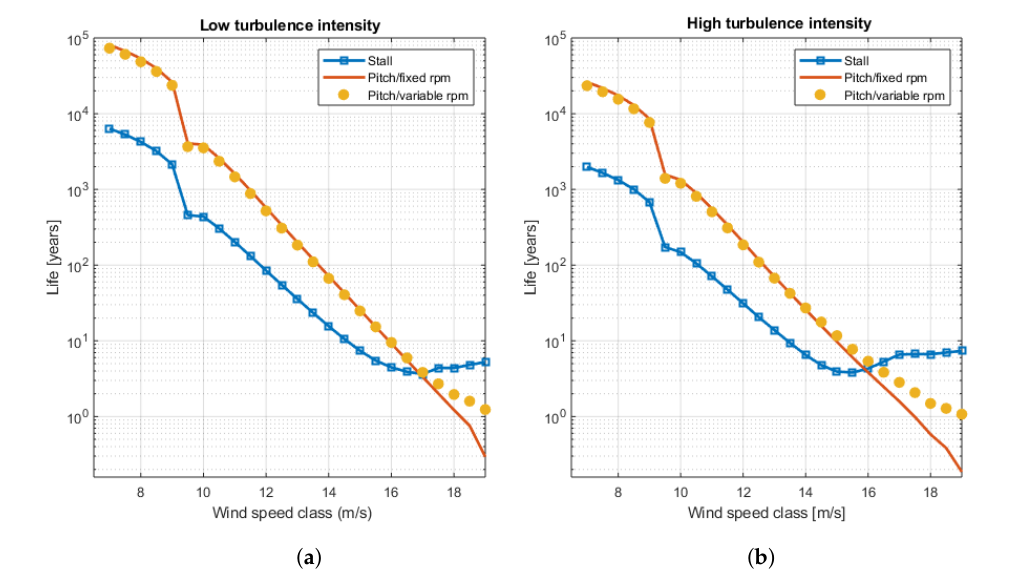
Figure 11. Fatigue life as a function of the wind speed class for all three power regulation schemes. ( a ) Low turbulence intensity. ( b ) High turbulence